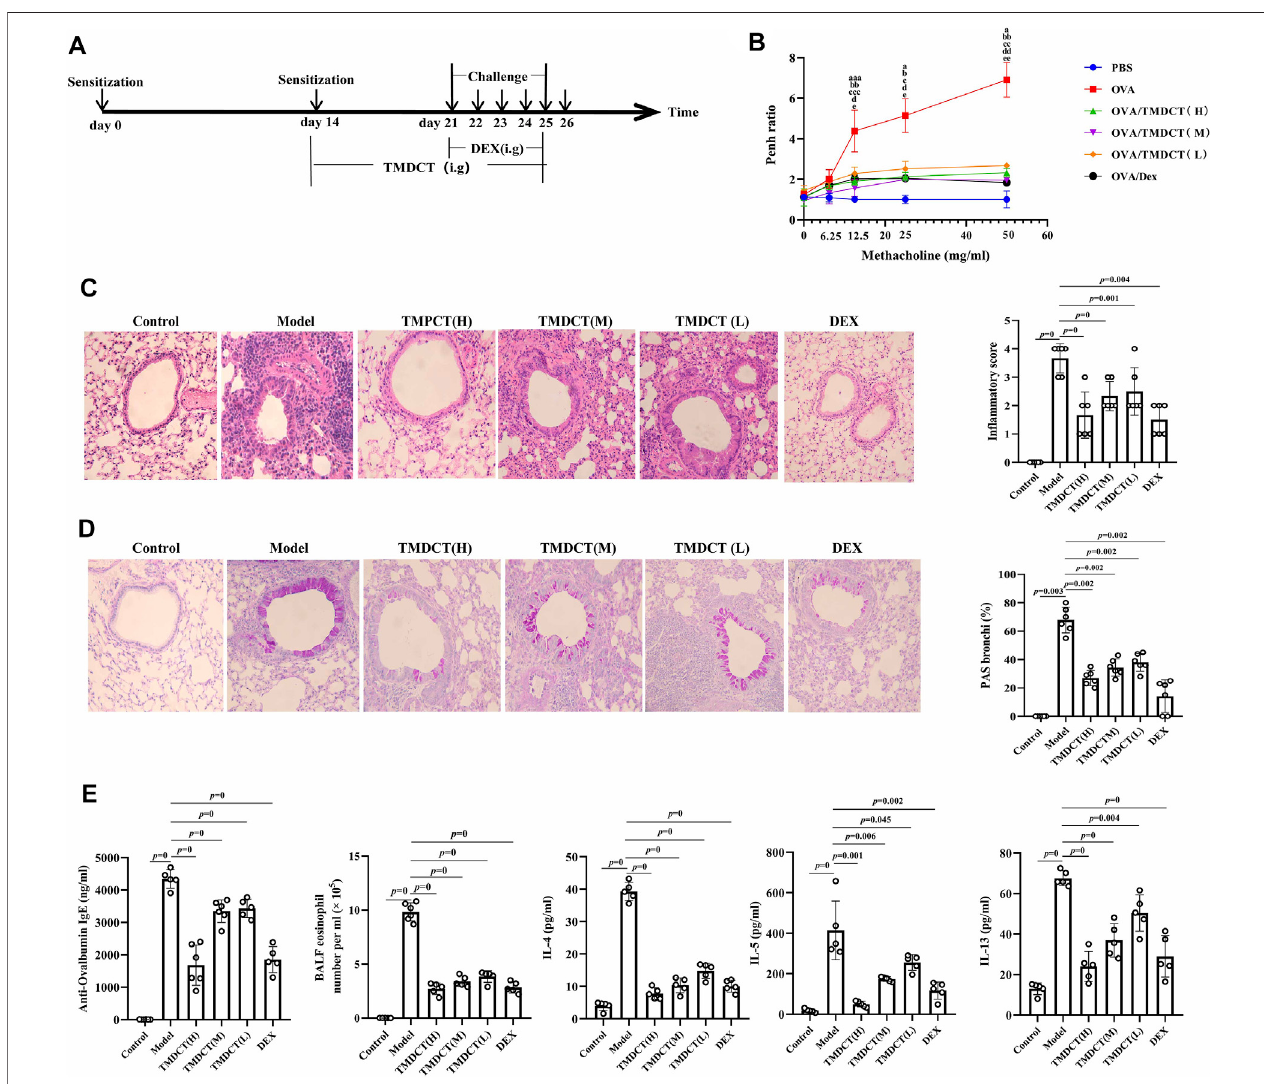
FIGURE1| TMDCTcanalleviate allergicin fl ammation ineosinophilic asthmaBALB/cmice. (A) Experimental protocol foreosinophilicasthmainducedbyOVAand treatment administration. (B) Lung function experiments. Detection the Penh value when the methacholine concentration is 0, 6.25, 12.5, 25, 50 mg/ml respectively. Penh ratio (average Penh in the 5-minute interval with methacholine divided by the average Penh in the 5-minute interval with PBS). a, p < 0.05 vs. Control; aa, p < 0.01 vs.Control;aaa, p ≤ 0.001vs.Control.b, p < 0.05vs.TMDCT(H);bb, p < 0.01vs.TMDCT(H);bbb, p ≤ 0.001vs.TMDCT(H).c, p < 0.05vs.TMDCT(M);cc, p < 0.01 vs. TMDCT(M); ccc, p ≤ 0.001 vs. TMDCT(M). d, p < 0.05 vs. TMDCT(L); dd, p < 0.01 vs. TMDCT(L); ddd, p ≤ 0.001 vs. TMDCT(L). (C) Left: HE staining of lung tissues; Right: In fl ammatory score results. (D) Left: PAS staining of lung tissues; Right: Total lung in fl ammation was de fi ned as the average of the peribronchial and perivascular in fl ammation scores. (E) Detection ifspeci fi cOVA-IgE inserum; eosinophilscount inBALF; detection ofcytokines IL-4,IL-5, IL-13. Allthe valuesareexpressed asmean +/- SEM. n = 4-5 animals per group.